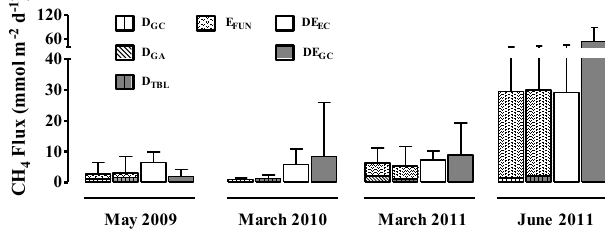
Figure 3. Inter-comparison of the estimates of CH 4 emissions obtained using the variety of methods deployed during the four field campaigns. Note that no ebullition was measured in March 2010. D GC : Diffusion from floating chamber (FC) and post-analysis with gas 4 chromatography, D TBL : Diffusion calculated by thin boundary layer (TBL) method from 5 surface CH 4 concentrations, D GA : Diffusion from FC and in situ gas analyser, E FUN : Ebullition 6 from submerged funnel, E GA : Ebullition from FC and in situ gas analyser, DE EC : Total 7 emissions measured by eddy covariance, DE GC : Total emissions by FC (diffusion + ebullition) 8 affected by ebullition. 9